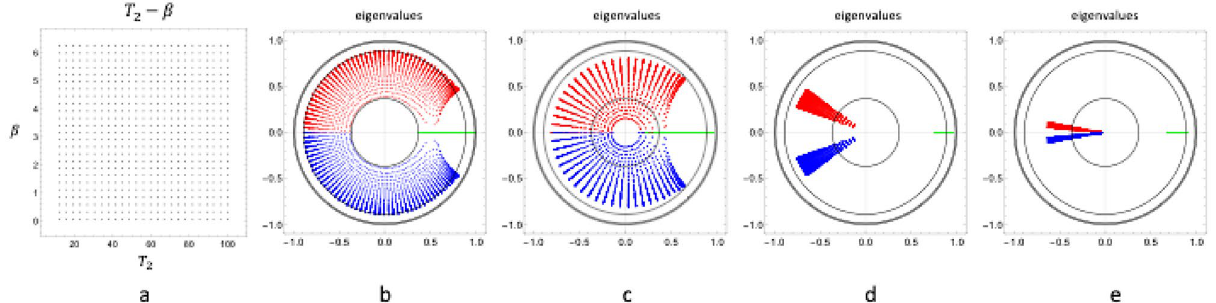
Figure 3. (a) T 2 − β species: parameter space, (b–e) are the eigenvalue maps on the complex plane where three eigenvalues belong to each parameter species: red and blue are the complex eigenvalues, green represents the real eigenvalue. Eigenvalues of the repeated α x propagator are shown in (b) . The α x − α y propagator with excitation flip angle α = 30 ◦ is shown in (c) , and in (d) “ α x − α x + δ ” scheme with α = 150 ◦ and δ = 75 ◦ . The eigenvalue space for α x − γ y − α y − γ x with α = 30 ◦ and γ = 175 ◦ is shown in (e) . For all maps T 1 =878 ms and T R =12 ms. In (c) one eigenvalue point belongs to the two β and β + 180 ◦